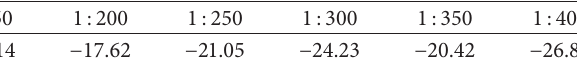
Figure 1: Unconfined compressive strength of red clay with different ISS/H Table 6: The ξ potential of red clay reinforced by ISS with different ISS/H